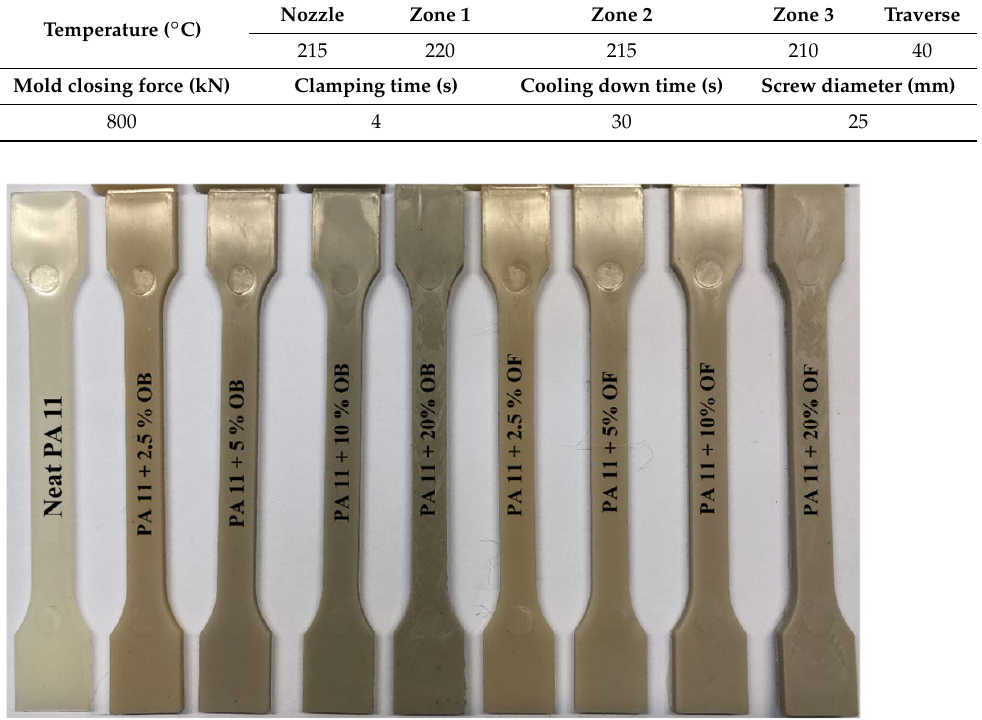
Table 4. Injection process parameters.